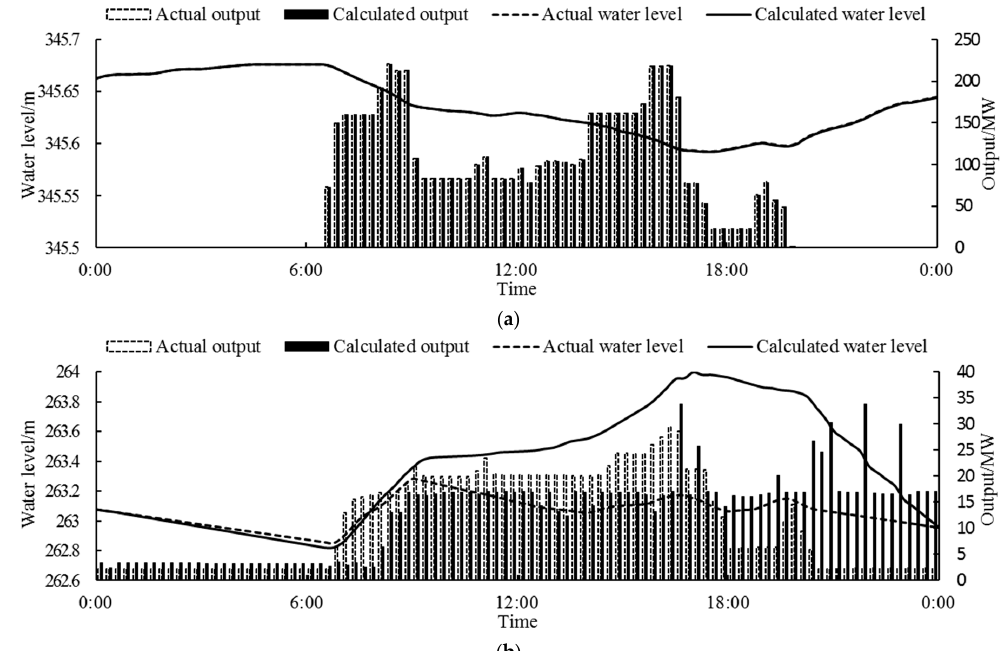
Figure 10. Comparison between the optimal and the actual operation schemes. ( a ) Pankou; ( b ) Xiaoxuan.